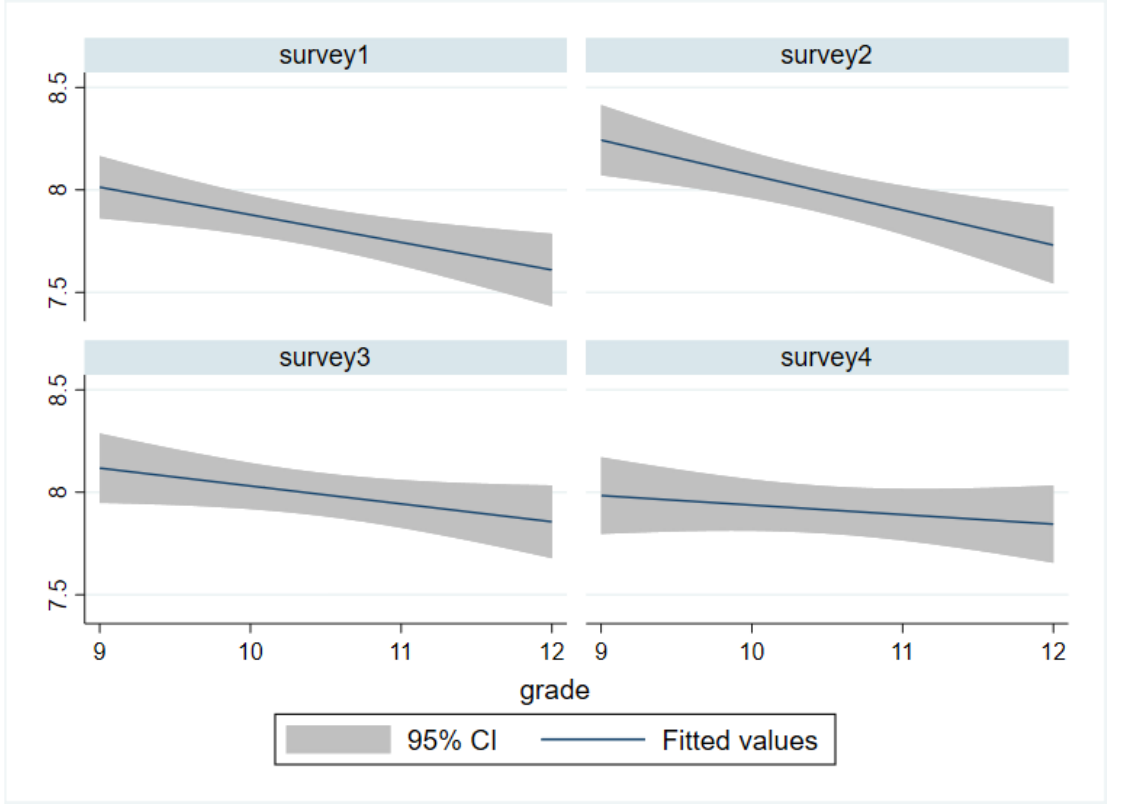
Figure 1. Linear fit with confidence intervals of life satisfaction by grade and survey.